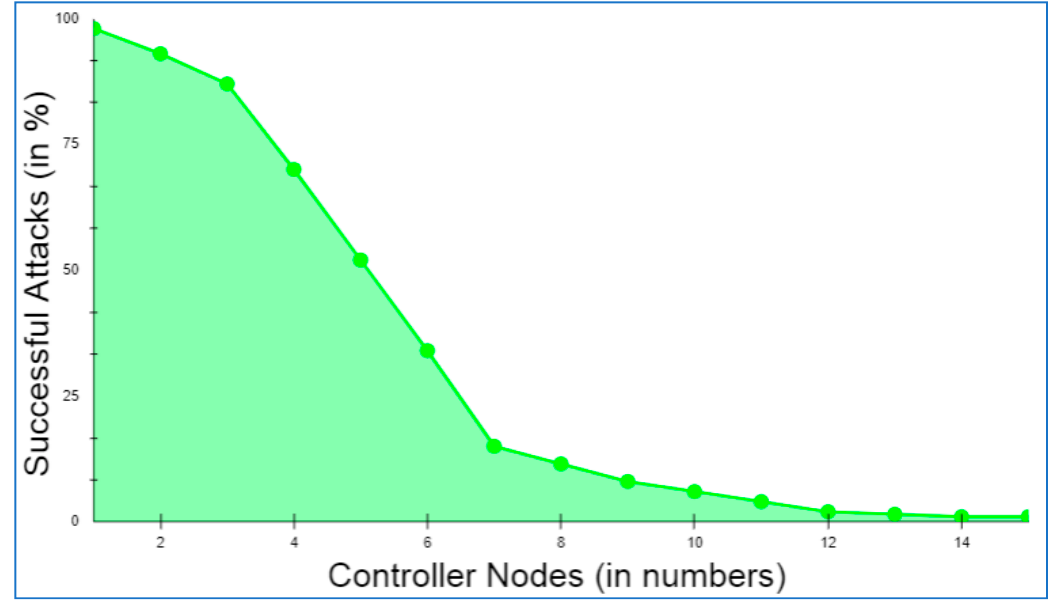
Figure 6. Success percentage in the attacks with respect to the number of controllers.